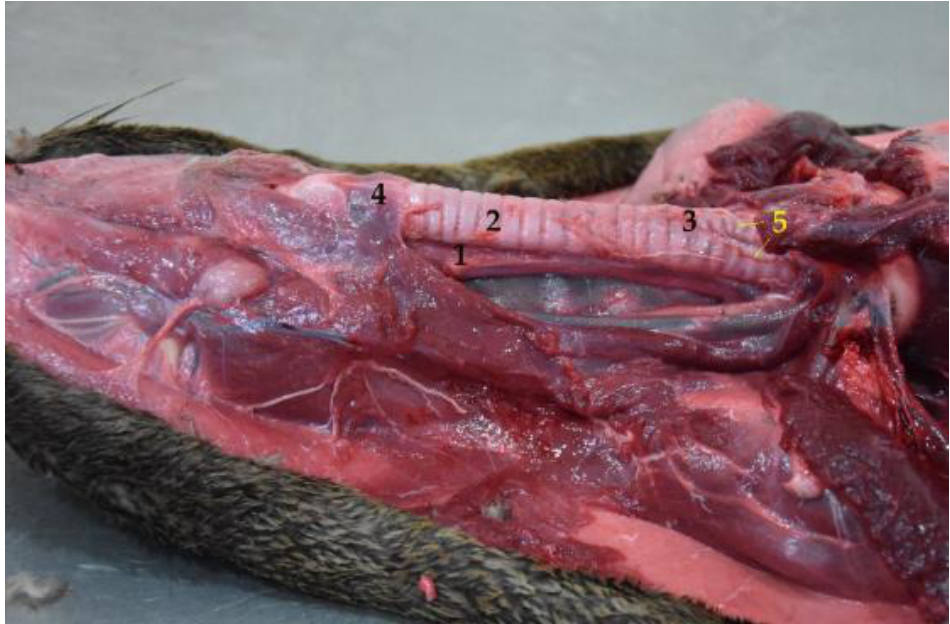
Figure 5. Cervical region with esophagus and trachea in situ (body in dorsal recumbency). Note the dorsal position of the esophagus in relation to the trachea. ( 1 ) Esophagus; ( 2 ) trachea; ( 3 ) tracheal bifurcation in the cervical region; ( 4 ) larynx; ( 5 ) bronchi.